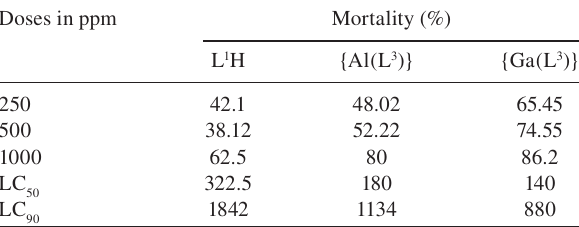
Table 5 Toxicity of ligand L 1 H and its metal complexes against 20-day-old nymphs of C. trachypterus